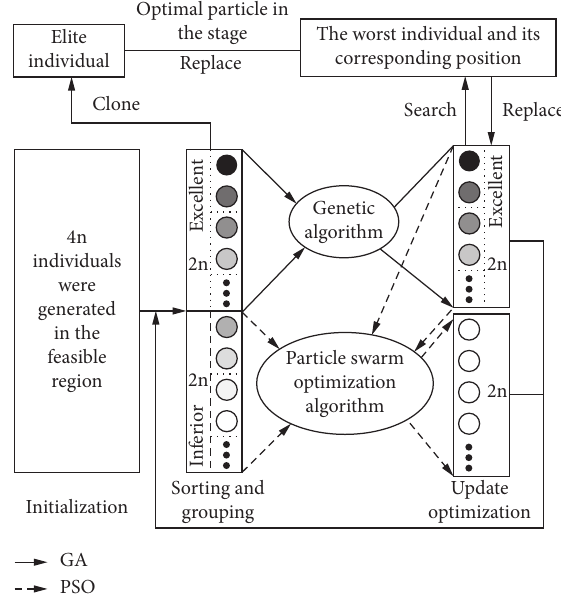
Figure 1: The implementation logic diagram of GA PSO joint